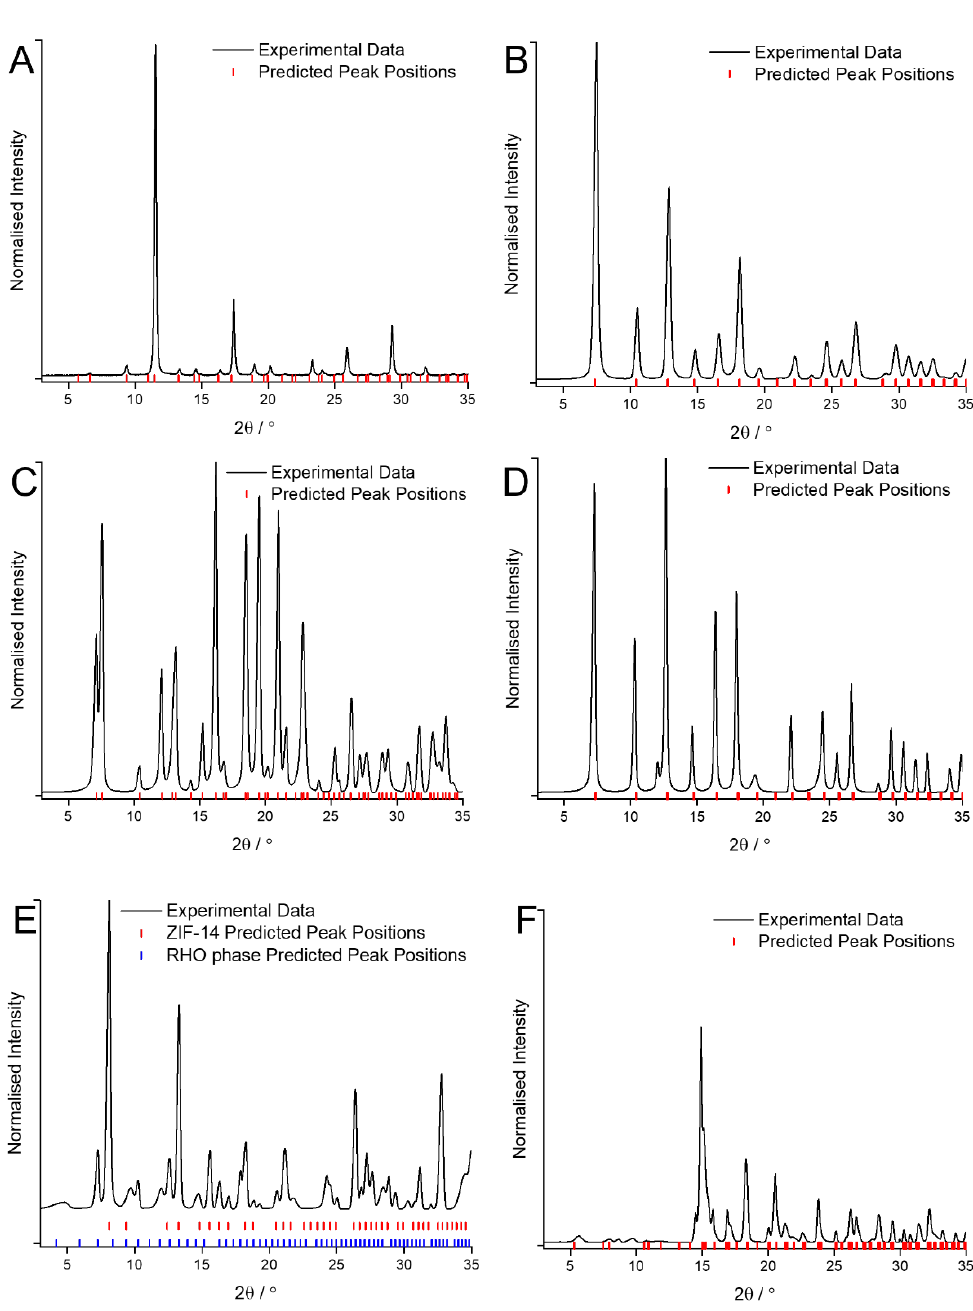
Figure A1. XRD patterns of the MOF coatings obtained using traditional solvents confirming their identities as: ( A ) HKUST-1; ( B ) ZIF-8; ( C ) ZIF-7; ( D ) ZIF-67; ( E ) ZIF-14; ( F ) ZIF-zni; compared against predicted peak position values [27,28].